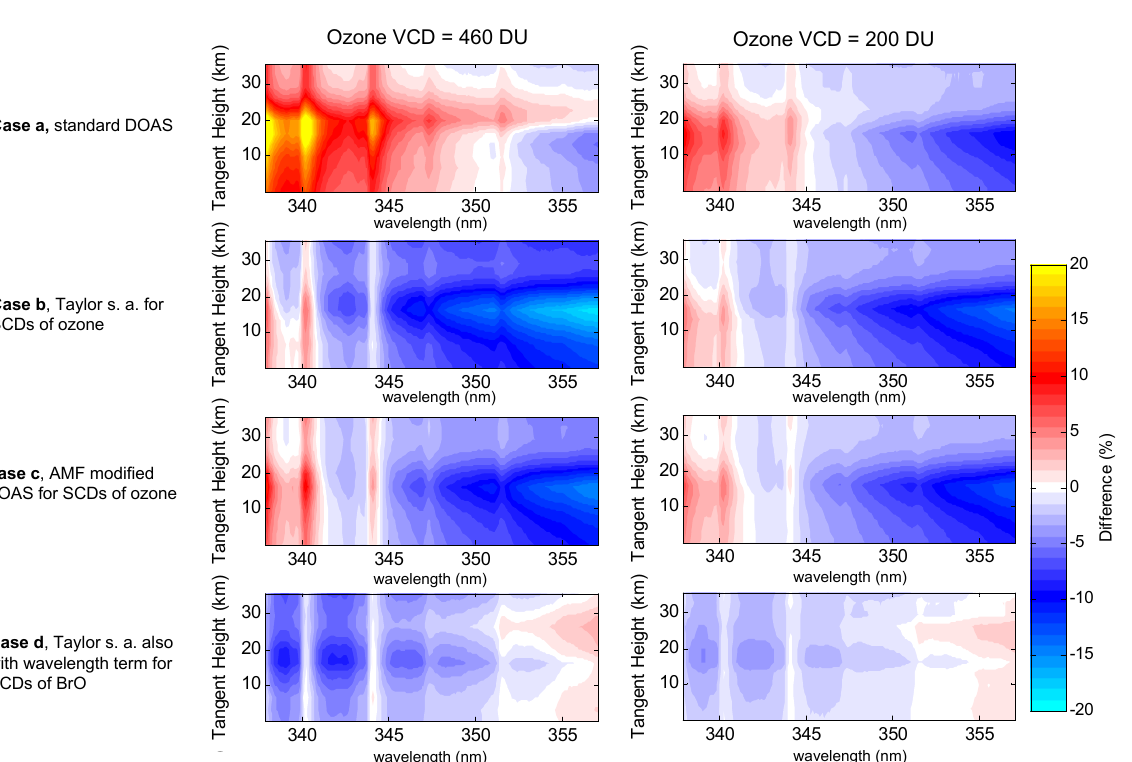
Fig. C1. Relative difference between retrieved SCDs of BrO and the true (simulated) SCDs as function of TH and wavelength for the studied cases (a) – (d) (see Table C1). The retrievals were performed for two different ozone profiles (with VCD=460DU, on the left, and 200DU, on the right, see Fig.